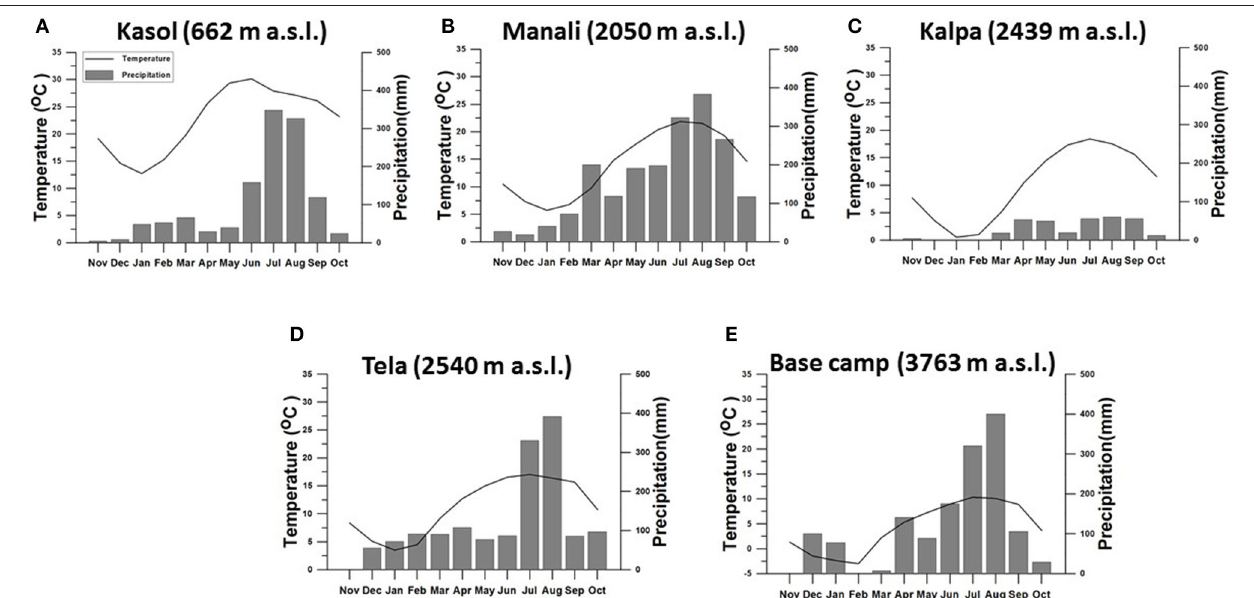
FIGURE 2 | Monthly distribution of temperature and precipitation at different elevations of the study basins. Sutlej–Beas basin (A–C) and upper Ganga basin (D,E)